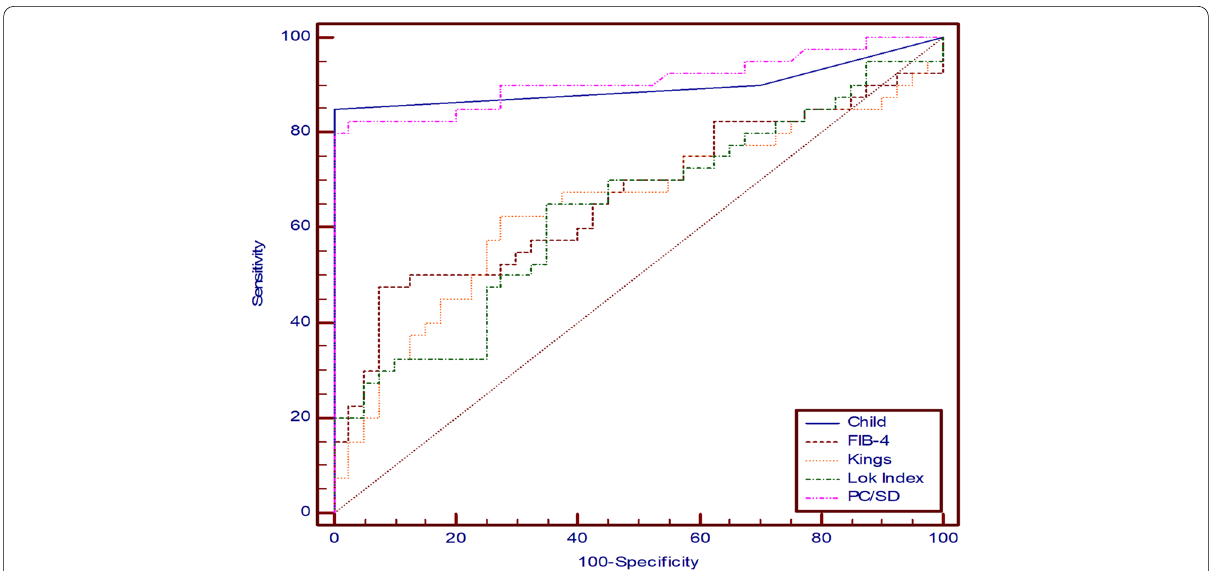
Fig. 1 Prediction of the presence of CSPH in HCV‑related liver cirrhosis